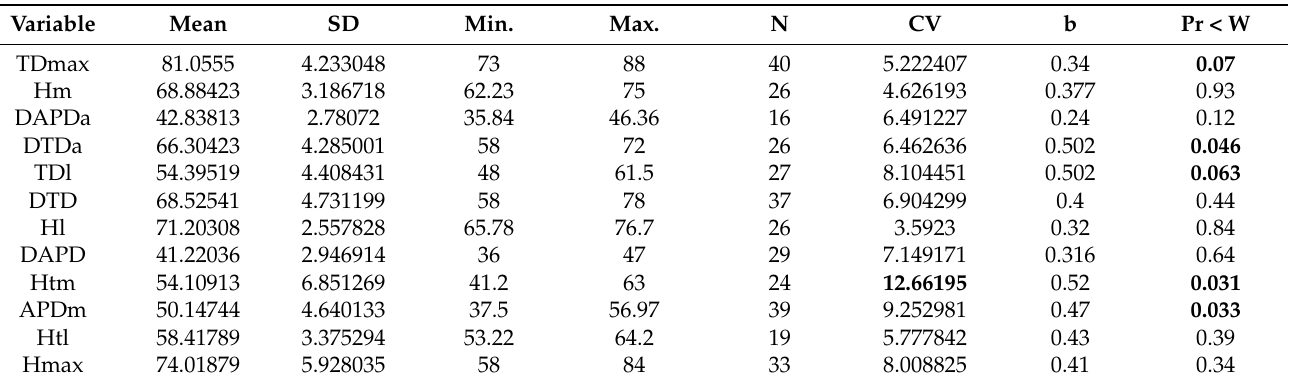
Table 3. Sex-combined statistics for astragalus variables.